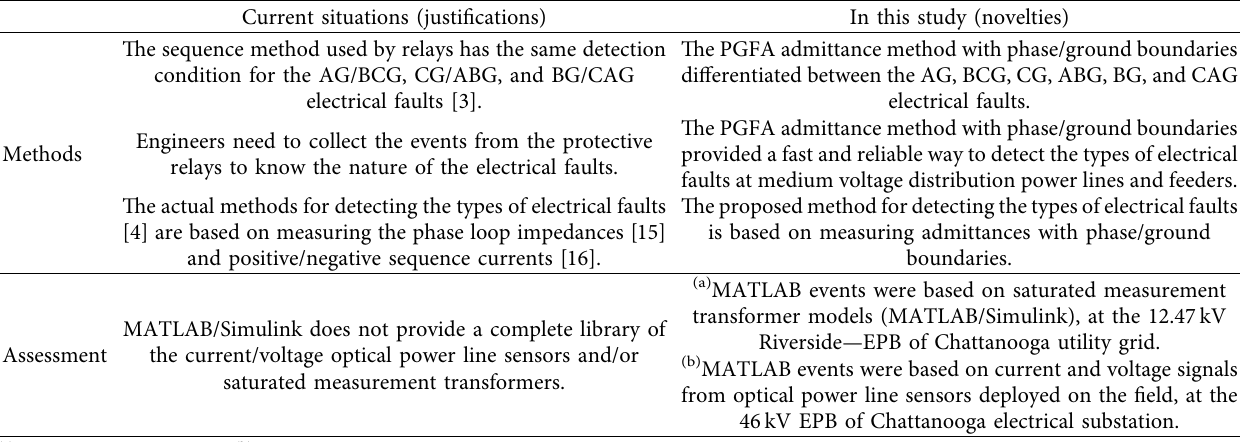
Table 1: Novelties of the PGFA admittance method with phase/ground boundaries and